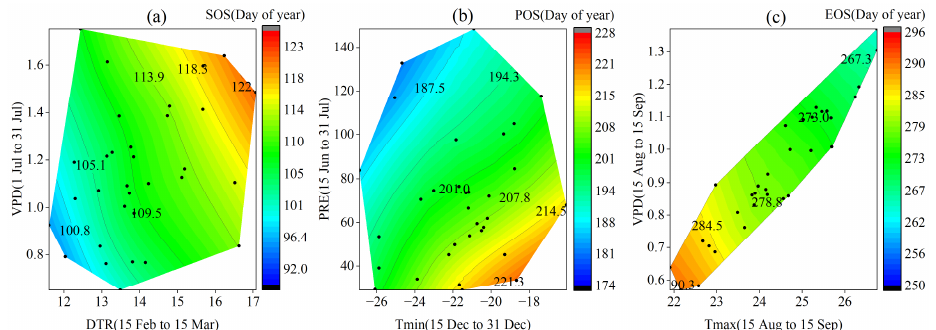
Figure 11. The combined response of the start, peak and end of the growing season (SOS, POS and EOS) to temperature and moisture during the critical periods. ( a ) The start of the growing season (SOS), ( b ) the peak of the growing season (POS) and ( c ) the end of the growing season (EOS). Variation in colour reflects changes in the phenology, and the black dots represent the phenology records from 1985–2018. Table 1. Parameters of stepwise regression for phenology and climatic factors in critical